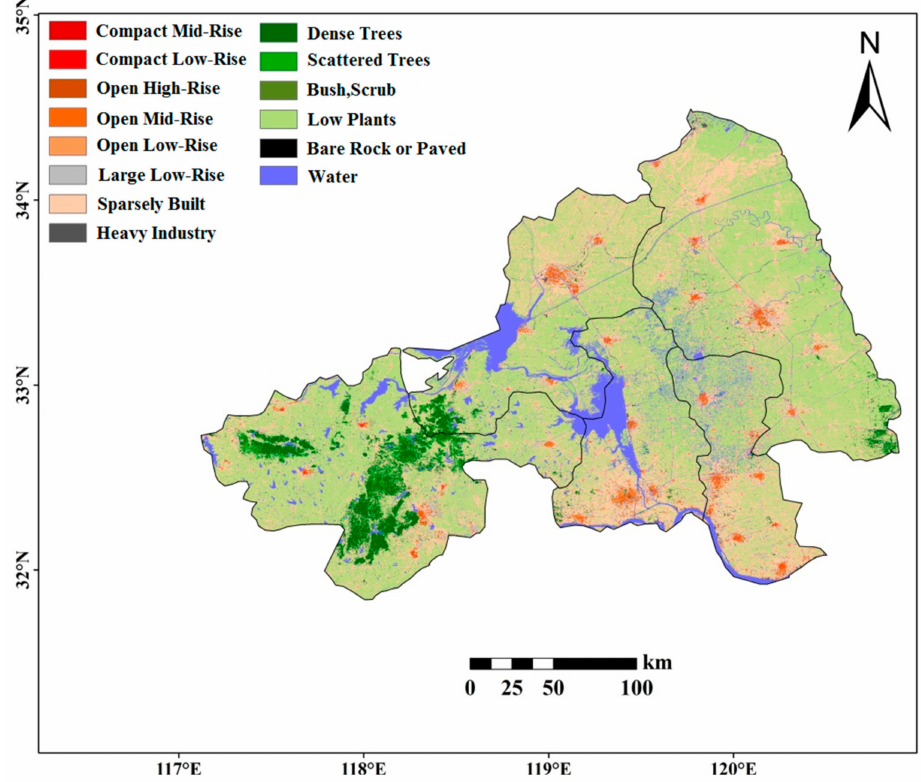
Figure 5. LCZ classification in the study